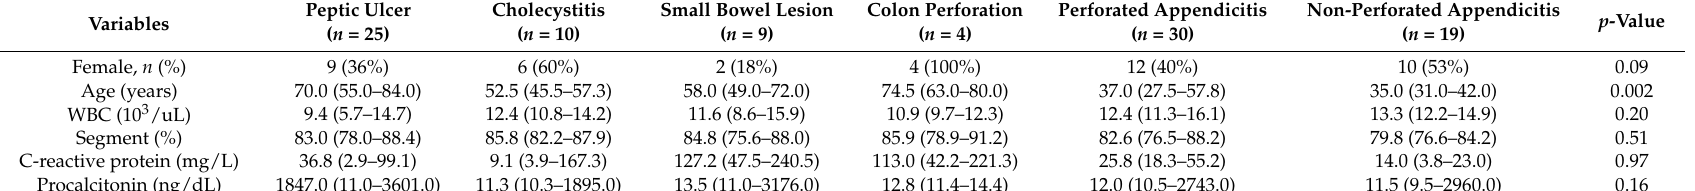
Table 1. Characteristics and inflammation profile of the patients. WBC: white blood cells.